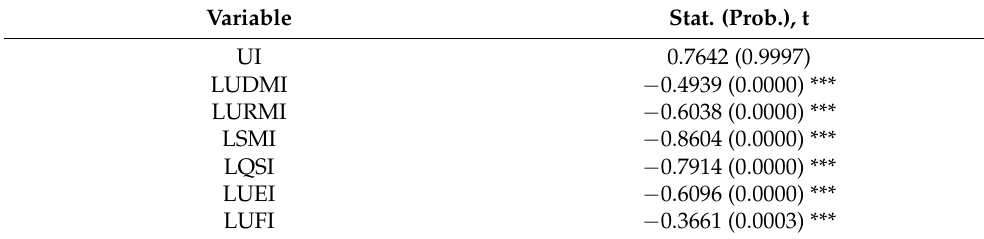
Table 4. HT unit root test.